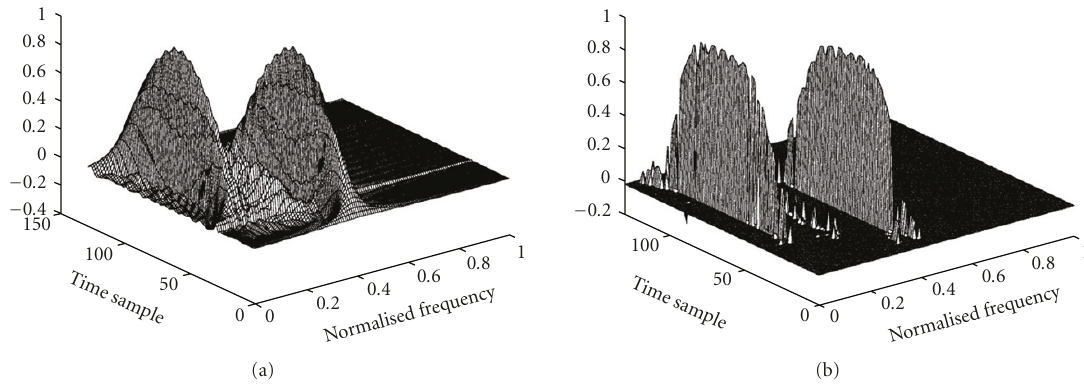
Figure 10: TFD results for x ( n ): (a) bionomial TFD (b) high-resolution bionomial TFD (adopted from Amin and Williams [130]).